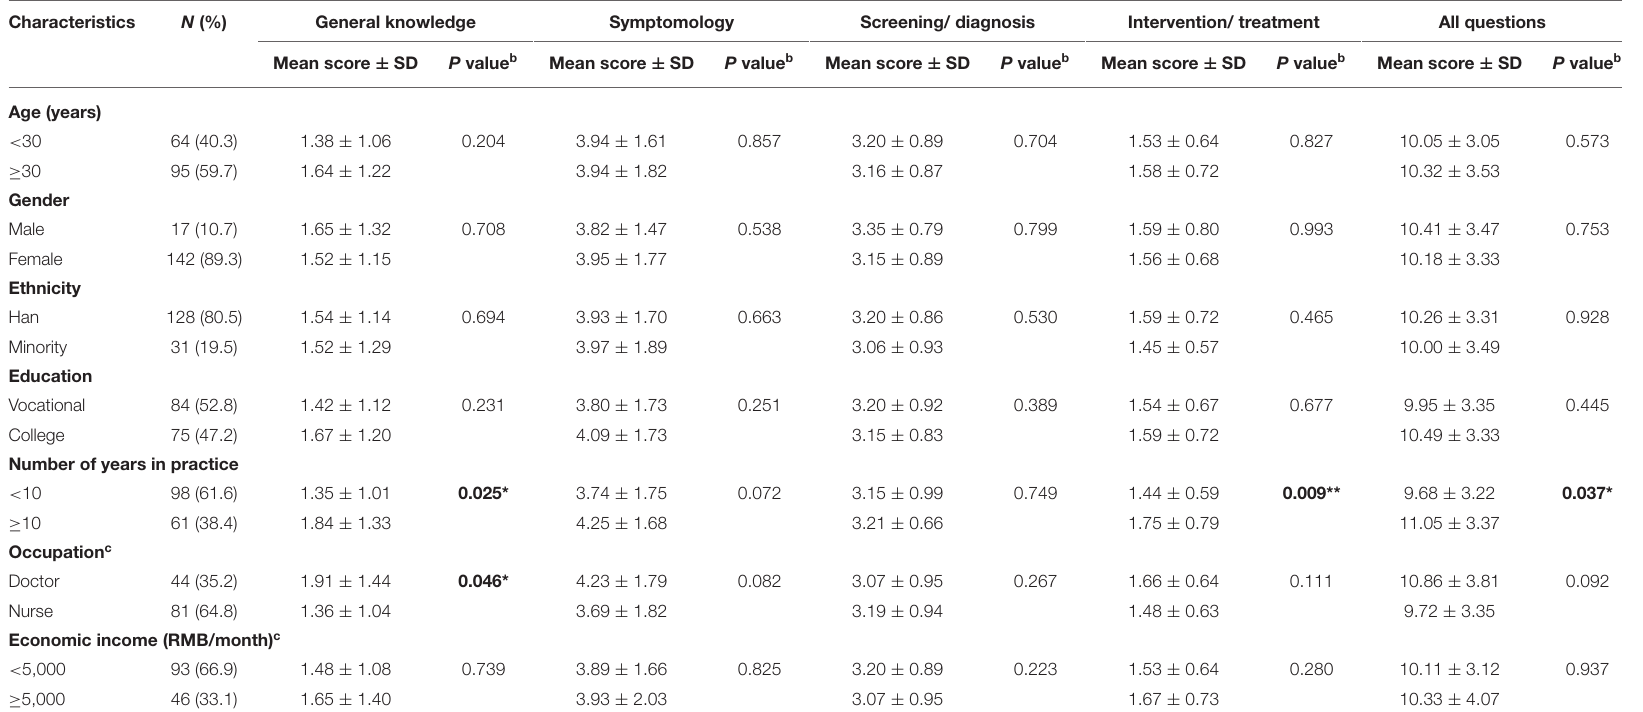
TABLE 6 | Association of the basic demographic characteristics of the participants with their awareness and knowledge scores a .